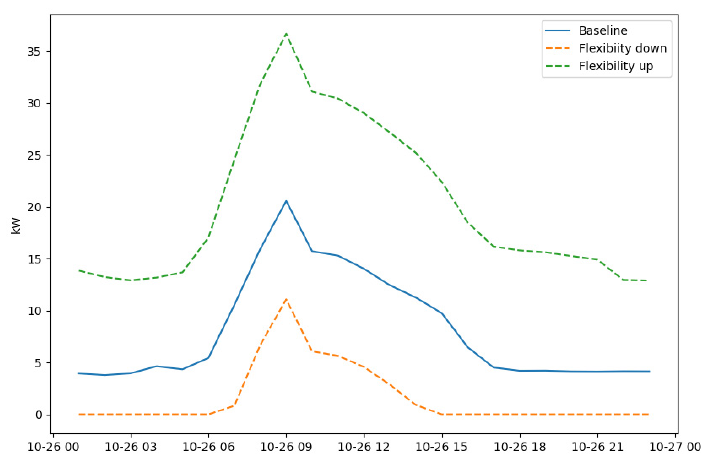
Figure 2. Flexibility map example. Day-ahead forecast of the baseline load, and maximum (up) and minimum (down) flexibility available in the building.